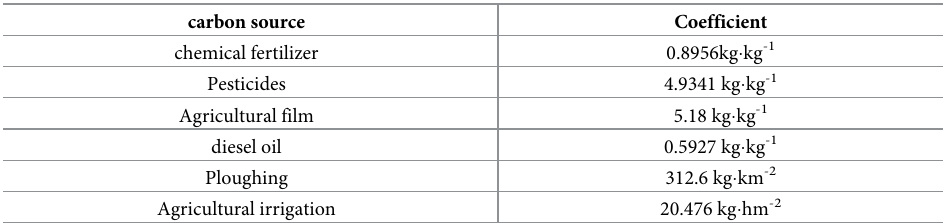
Table 1. Sources and coefficient of agricultural carbon dioxide